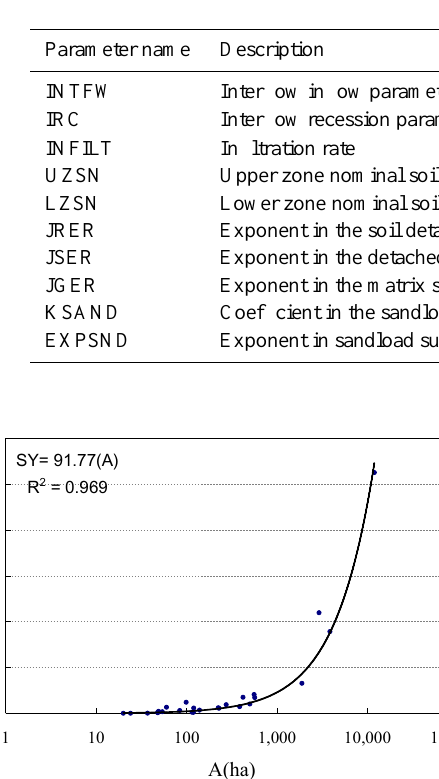
Table 3. Descriptions of HSPF Model Parameters.